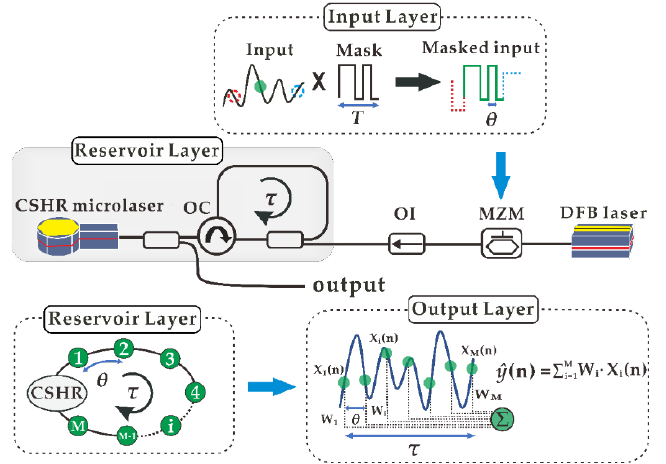
Figure 1. Schematic of delay-based reservoir computing system using CSHR microlaser optical feedback and injection. OC: optical circulator. OI: optical isolator. MZM: Mach–Zehnder modulator.